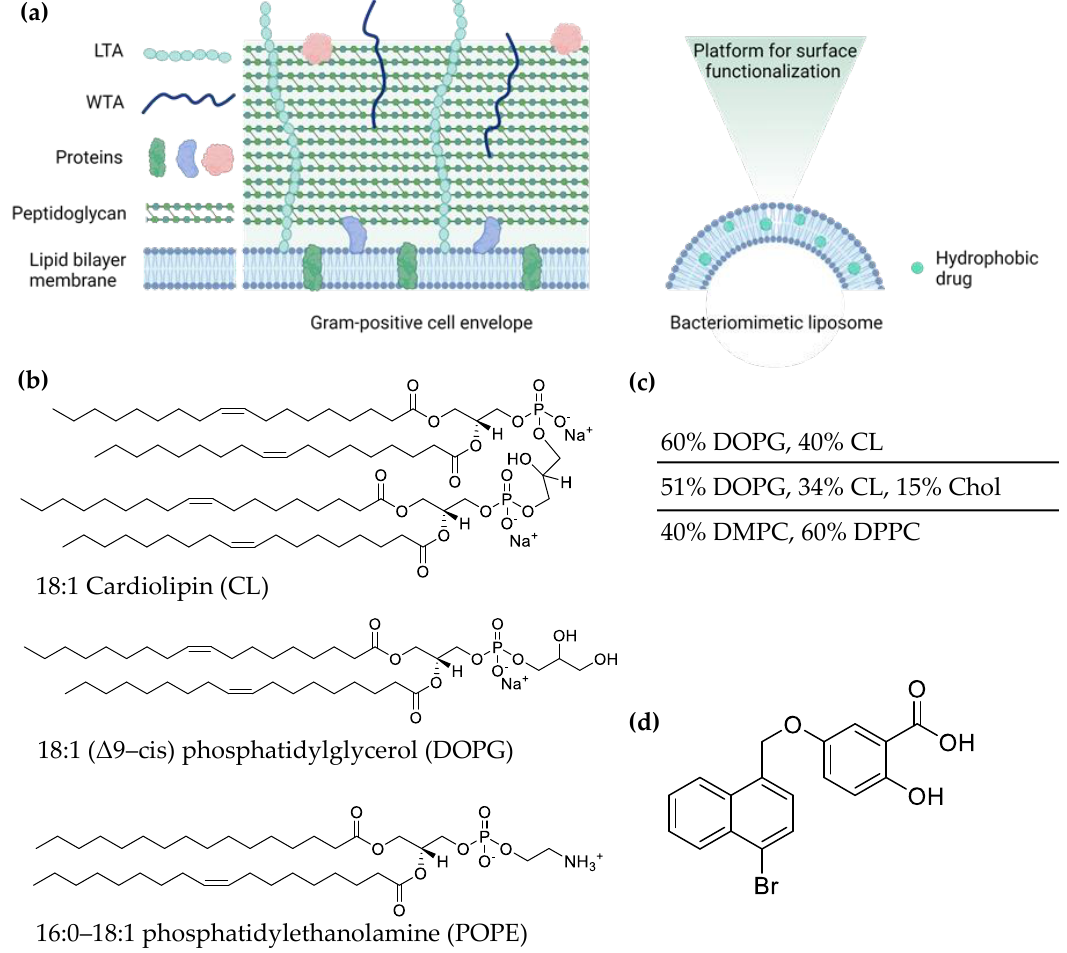
Figure 1. ( a ) Scheme of the Gram-positive cell envelope and bacteriomimetic DOPG/CL liposomes. LTA, lipoteichoic acid; WTA, wall teichoic acid. ( b ) Phospholipids present in the cell membrane of Gram-positive S. aureus and S. pneumoniae . ( c ) Lipid composition of liposomes prepared in this work. Phosphatidylcholine (PC) is the main phospholipid of eukaryotic cells. ( d ) Structure of HIPS5031 , an inhibitor of Energy-coupling factor (ECF) transporters that are responsible for micronutrient uptake in prokaryotes. Figure 1a was created with BioRender.com.